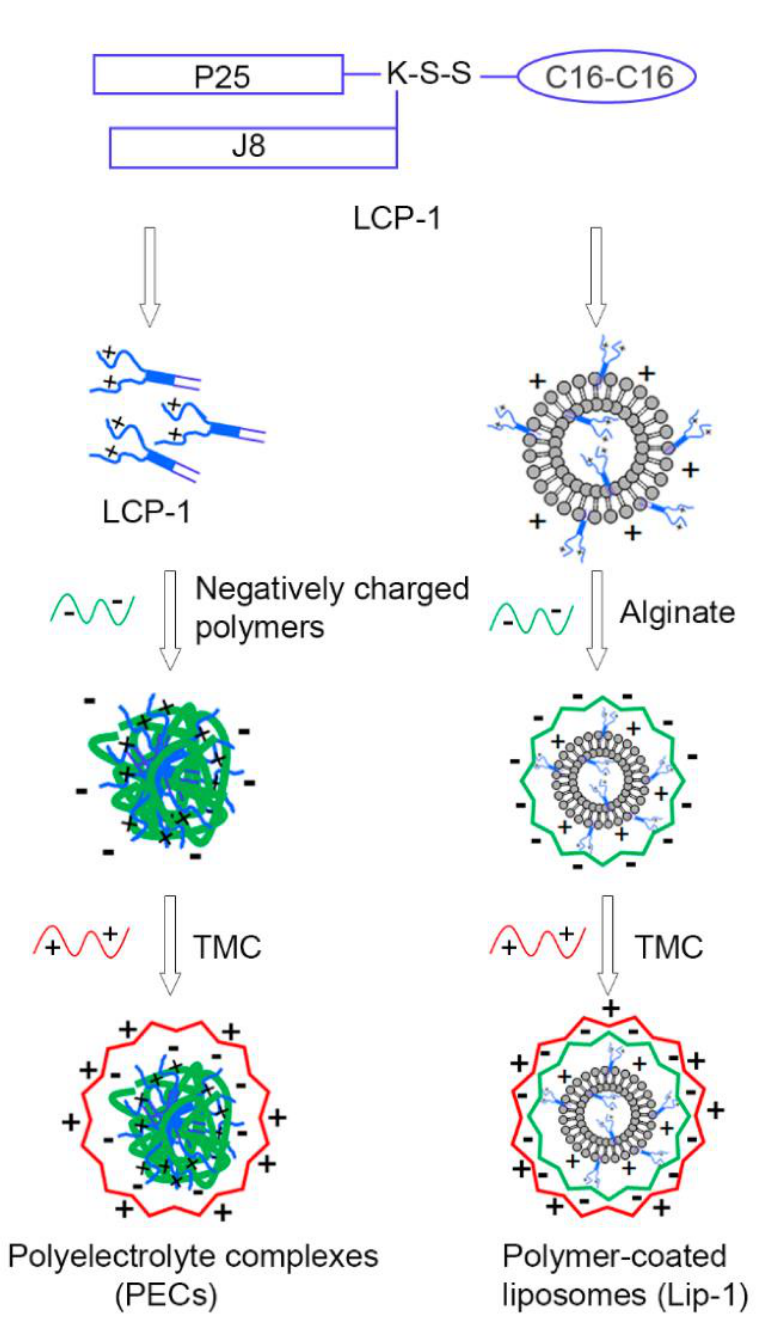
Figure 8. Schematic representation of the vaccine delivery systems developed by Zhao et al. [139]. Reprinted from an open-access source.